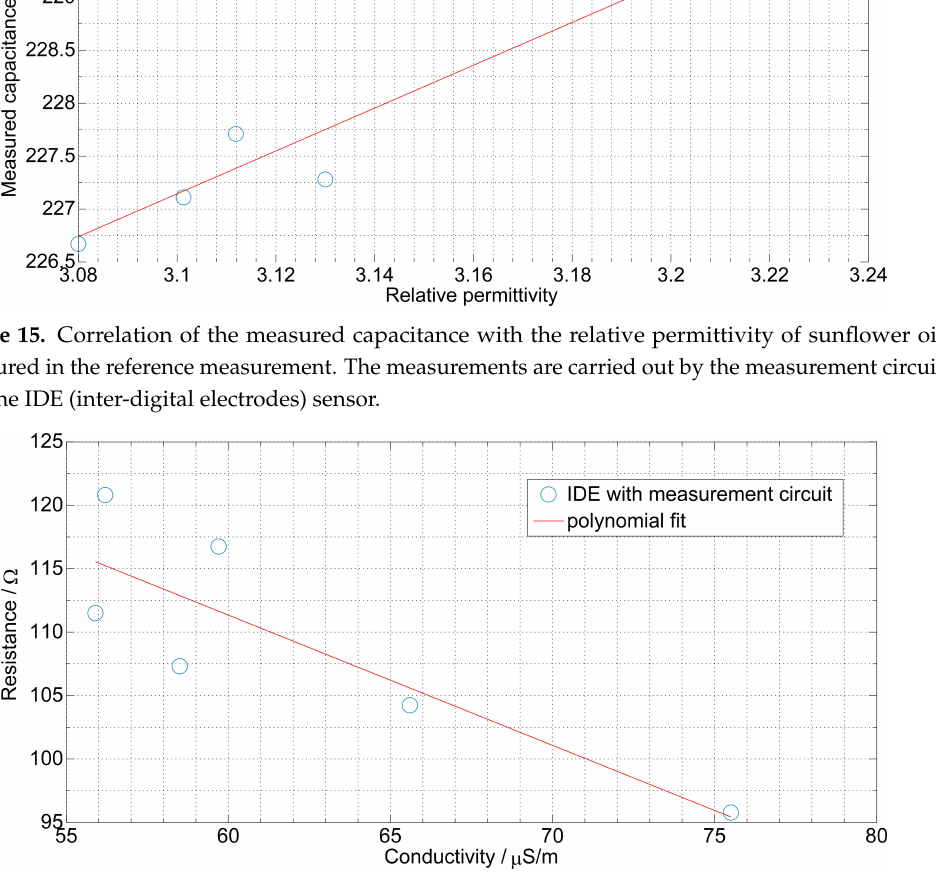
Figure 16. Correlation of the measured capacitance with the relative permittivity of sunflower oil measured in the reference measurement, the measurements are carried out by the measurement circuit and the IDE